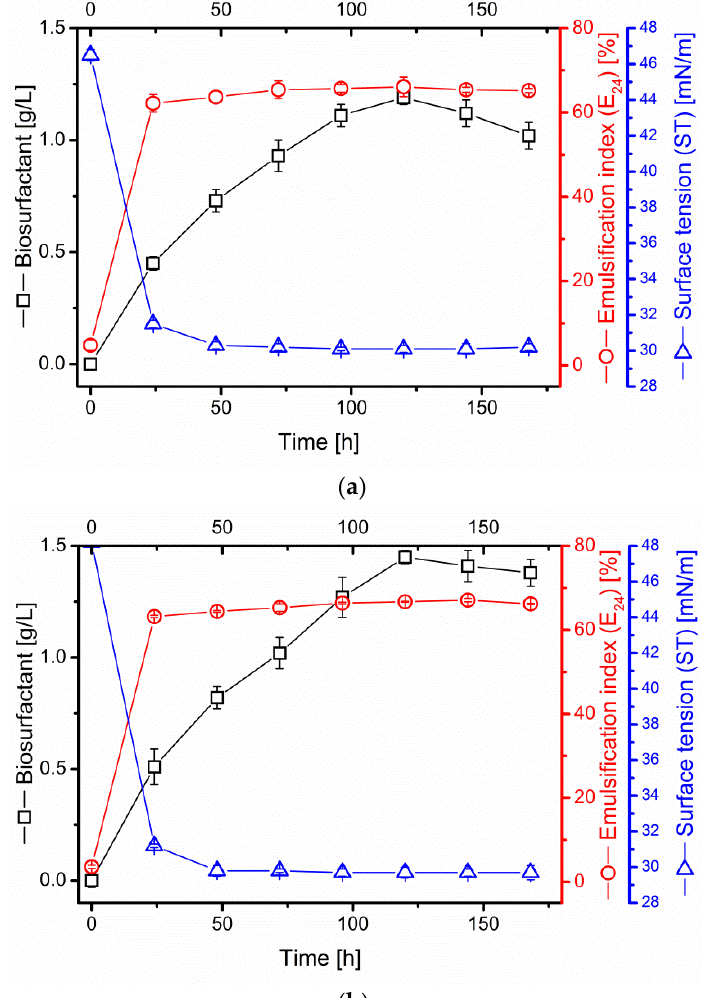
Figure 1. Effect of ( a ) sunflower and ( b ) rapeseed oil cake substrates (5% w / v ) in shake - flask cultures on biosurfactant production, pH, emulsification index (E 24 ) and surface tension (ST). The cultures were performed at 37 °C and 160 rpm for 168 h. The results represent the mean ± standard deviation of triplicate assays.